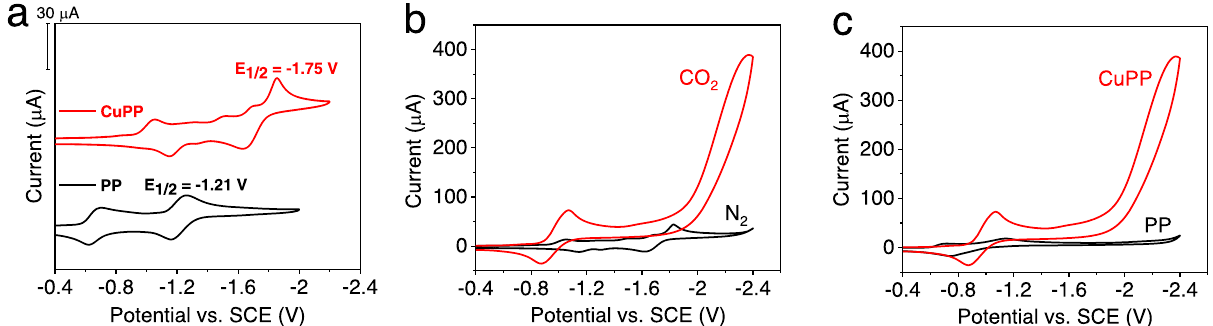
Fig. 4 Electrochemical data of CuPP and purpurin under N 2 or CO 2 . Experiments were performed in DMF containing 0.1 M TBAPF 6 at scan rate 0.1 V/s: a 1 mM CuPP (red) and 1 mM PP (black) under N 2 ; b 1 mM CuPP under N 2 (black) and CO 2 (red); c 1 mM CuPP (red) and 1 mM PP (black) under CO 2 . Source data are provided as a Source Data fi le.